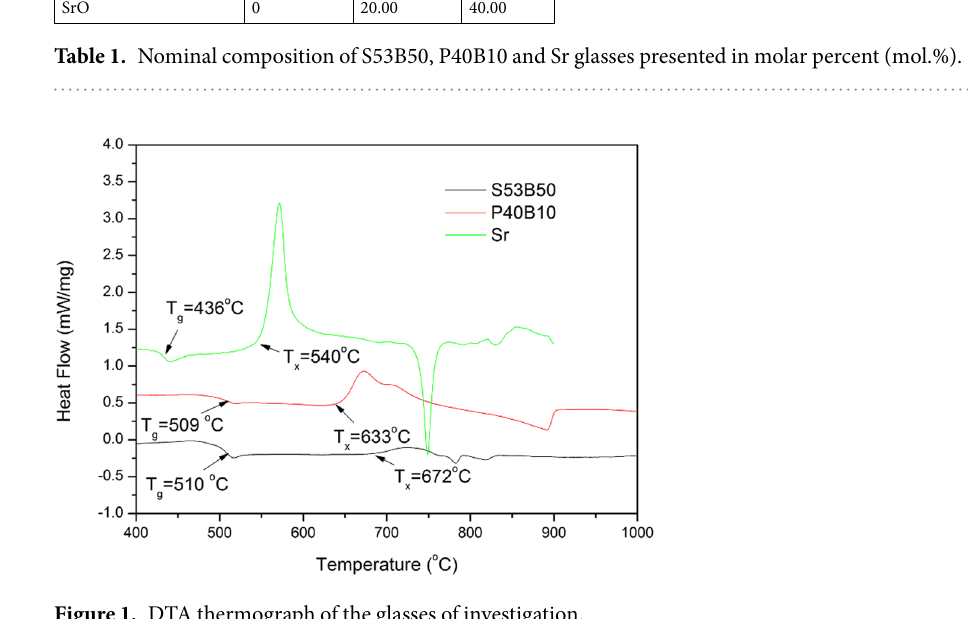
Figure 1. DTA thermograph of the glasses of